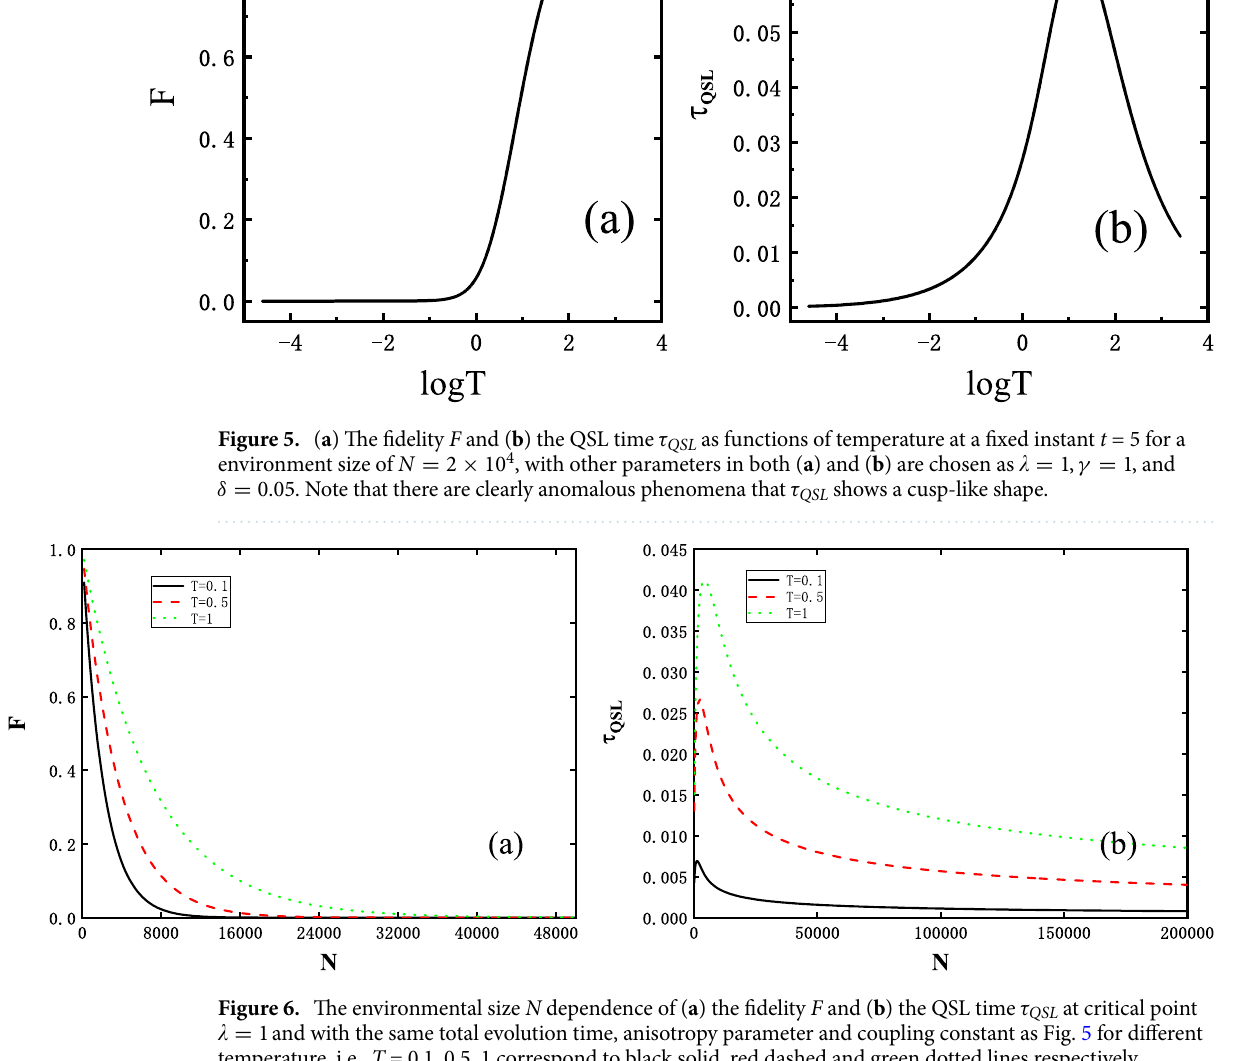
Figure 6. The environmental size N dependence of ( a ) the fidelity F and ( b ) the QSL time τ QSL at critical point (cid:31) 1 and with the same total evolution time, anisotropy parameter and coupling constant as Fig. 5 for different = temperature, i.e., T = 0.1, 0.5, 1 correspond to black solid, red dashed and green dotted lines